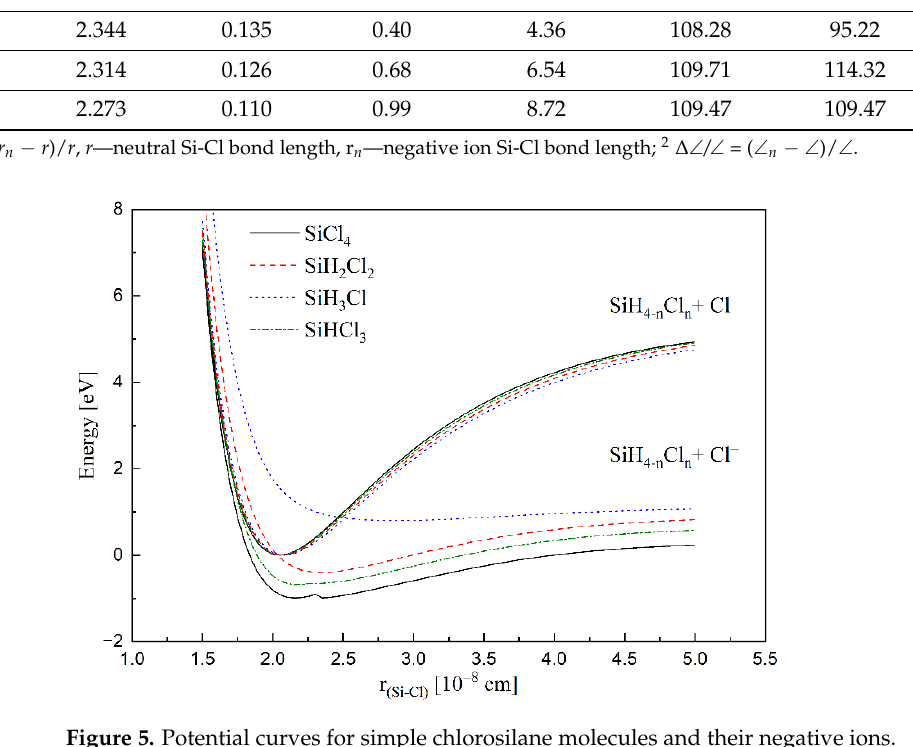
Figure 5. Potential curves for simple chlorosilane molecules and their negative ions.